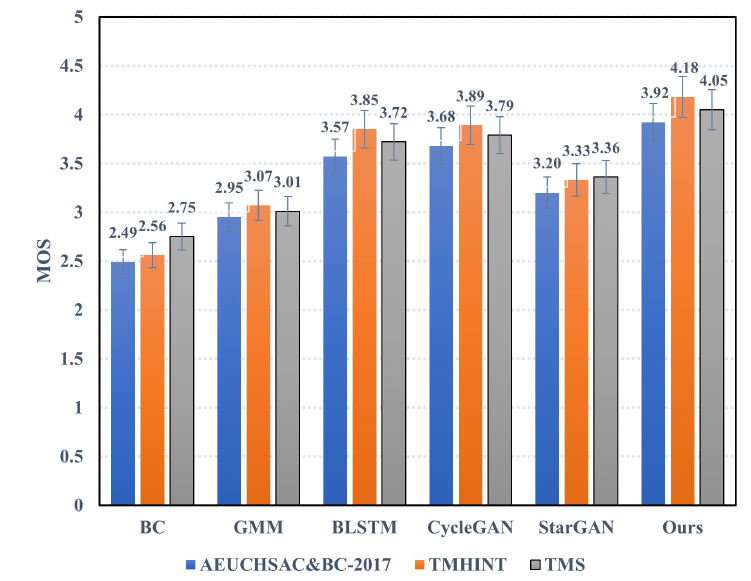
Figure 12. MOS with different BC speech enhancement